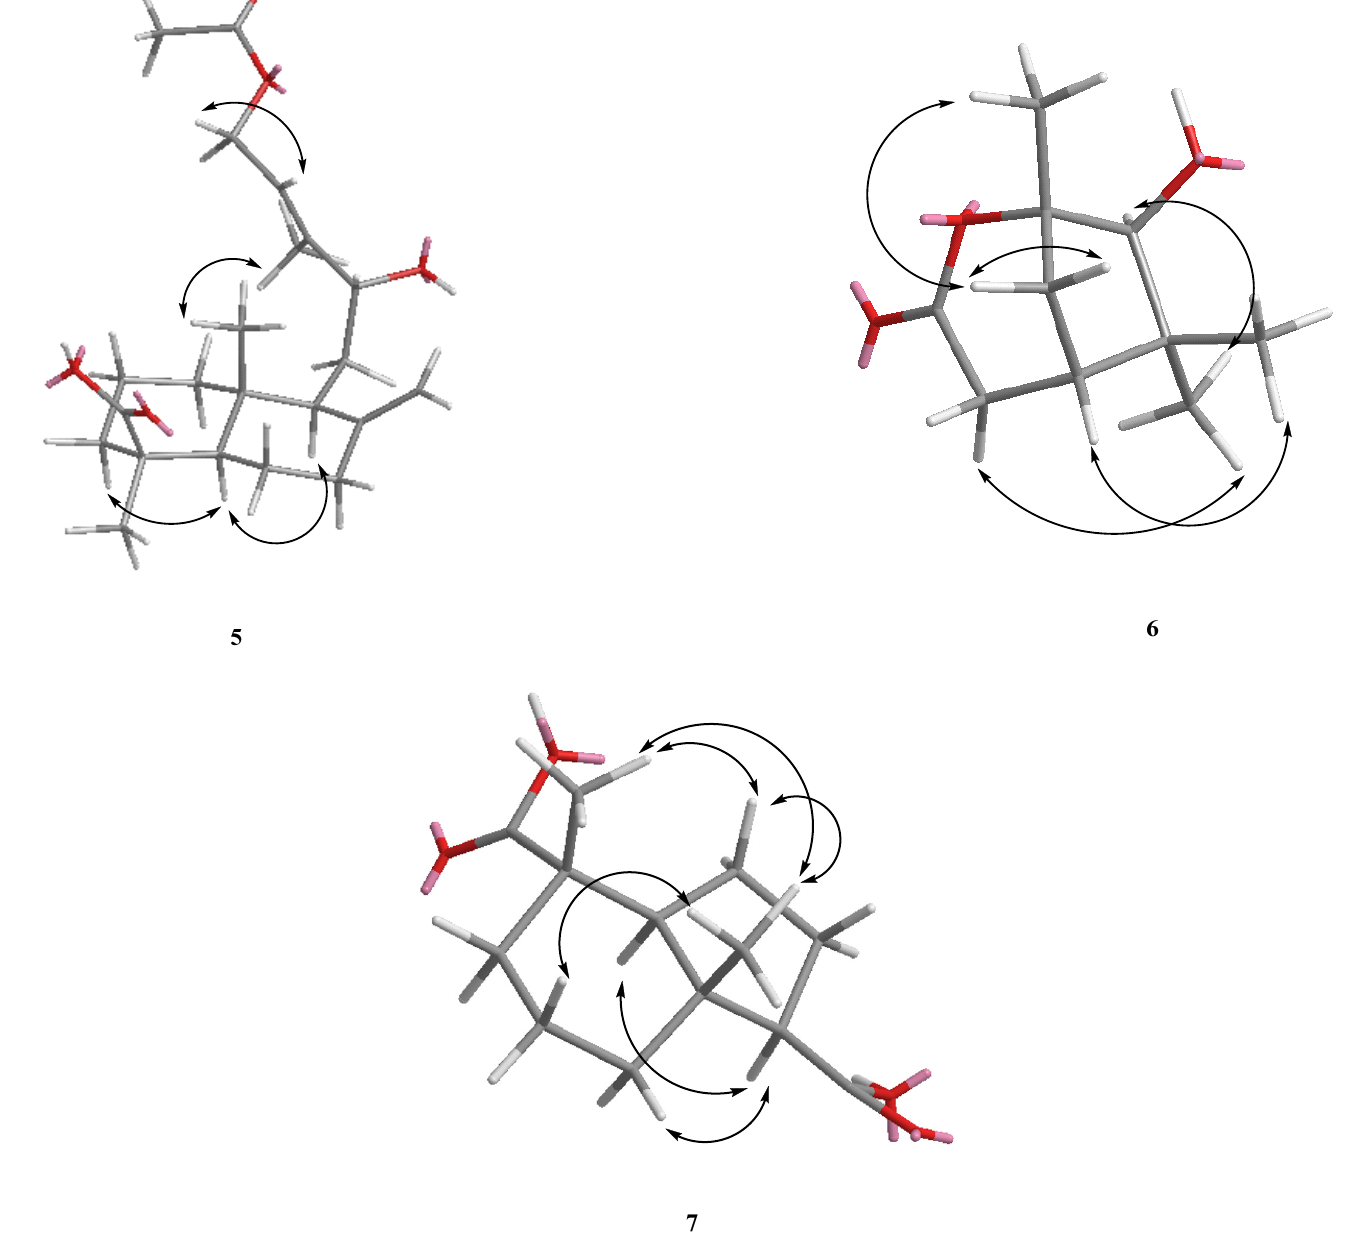
Figure 3. Major NOESY ( ↔ ) contacts of 1 ‒ 7 .